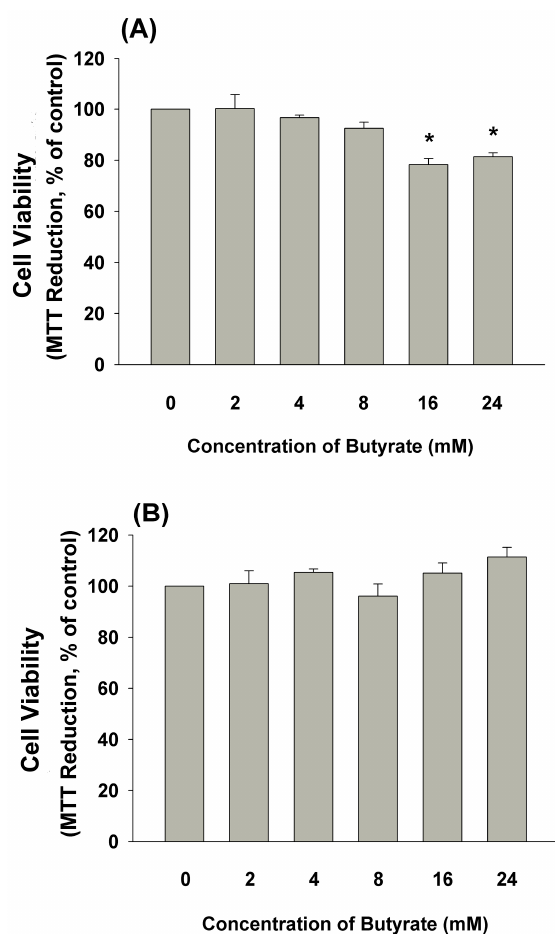
Figure 3. Effect of butyrate on the cell viability of MG63 cells: ( A ) MG63 cells (1 × 10,000 cells/24-well) were exposed to butyrate for 3 days, ( B ) roughly confluent MG63 cells (1 × 100,000 cells/24-well) were exposed to butyrate for three days. Cell viability was determined by 3-(4,5-dimethylthiazol-2-yl)-2,5-diphenyl tetrazolium bromide (MTT) assay. Results were expressed as a percentage of control (Mean ± SE). Statistically significant difference when compared with the control ( p < 0.05) denoted by *.